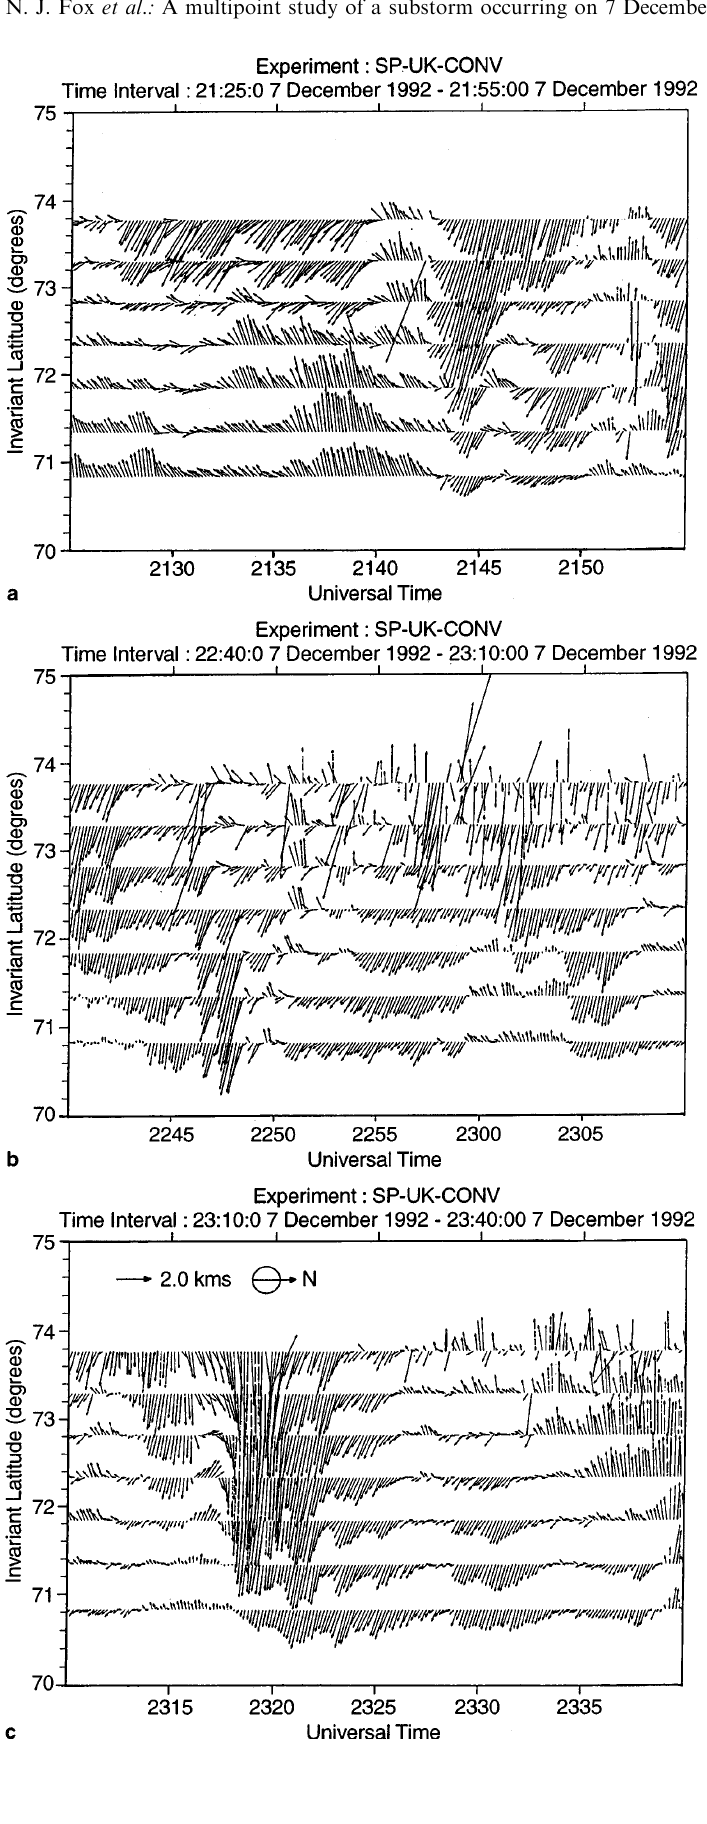
Fig. 13a–c. The three panels show the vectors deduced from the EISCAT CP-4-B experiment, which represent the velocity and direction of flow in the ionosphere. The vectors are rotated clockwise through 90 (cid:176) in order to reduce the congestion of the predominantly east/west flows. The panels are for time intervals a 2125–2155 UT, b 2240–2310, and